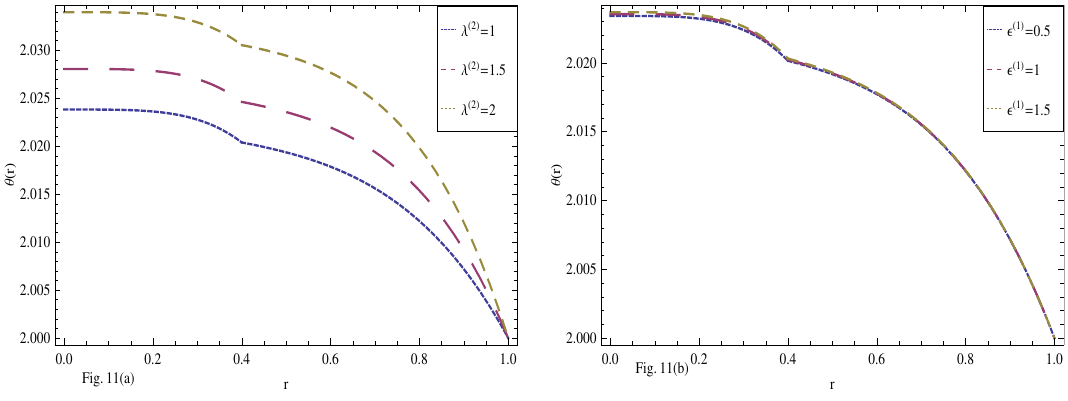
Figure 11. Effect of ( a ) λ ( 2 ) and ( b ) (cid:101) ( 1 ) on the temperatures of the two